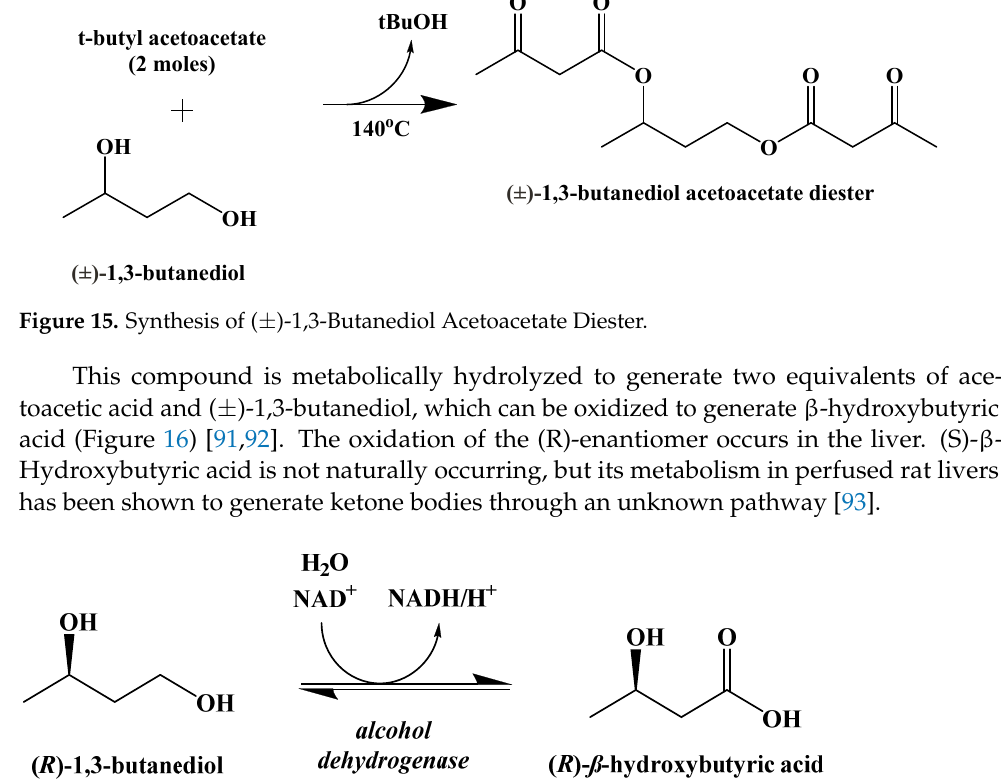
Figure 16. Oxidation of (R)- β -1,3-Butanediol in the Liver.